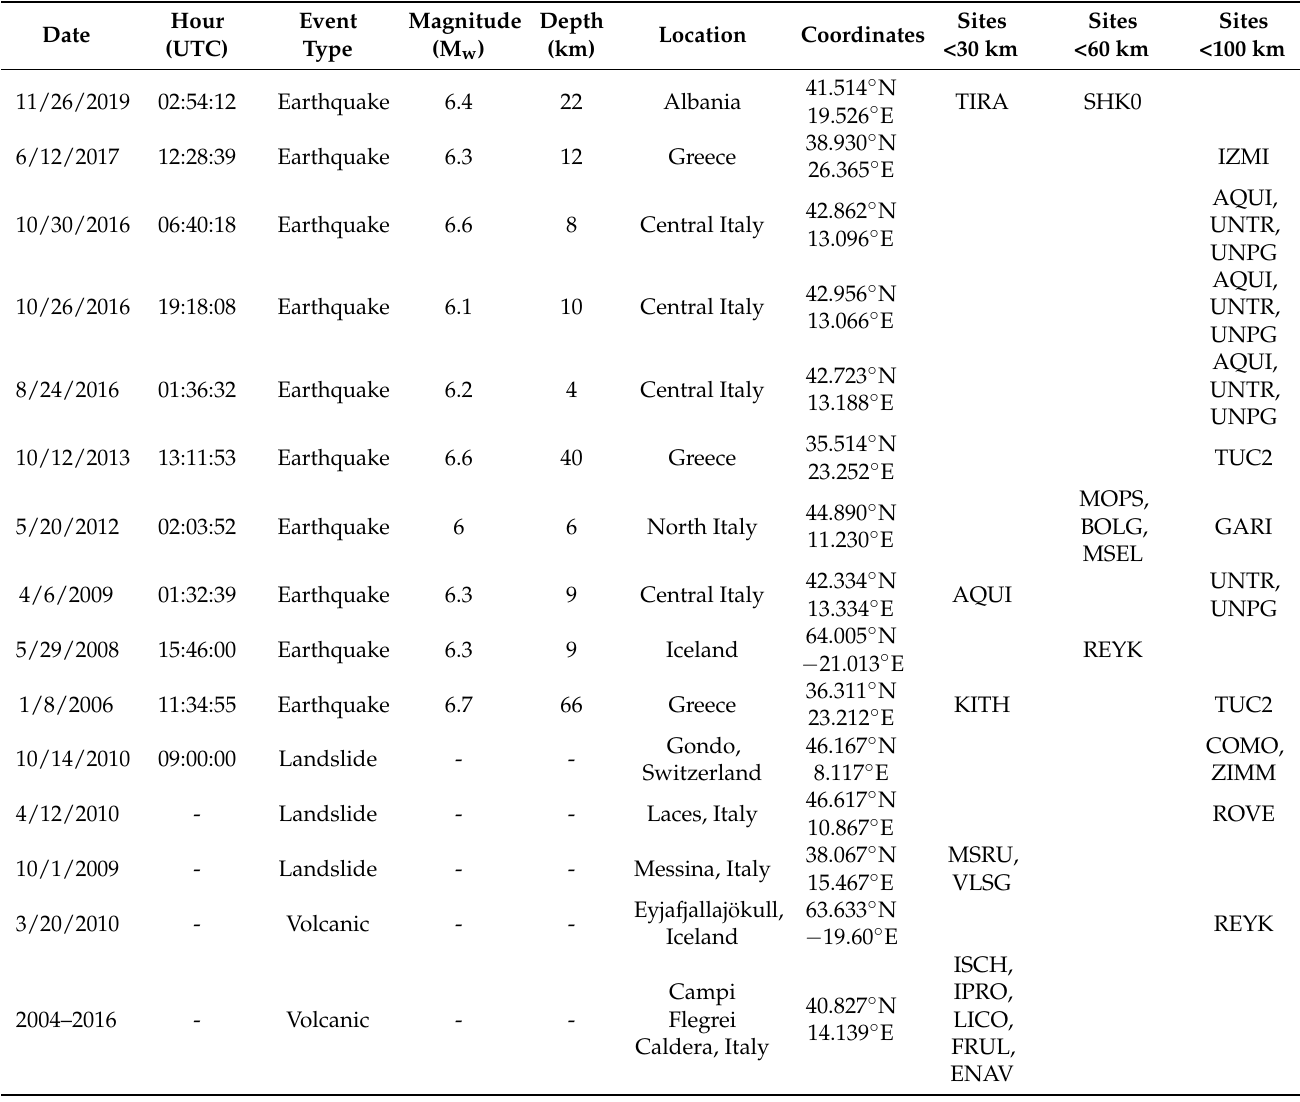
Table 1. Selected geophysical events from 2000 to